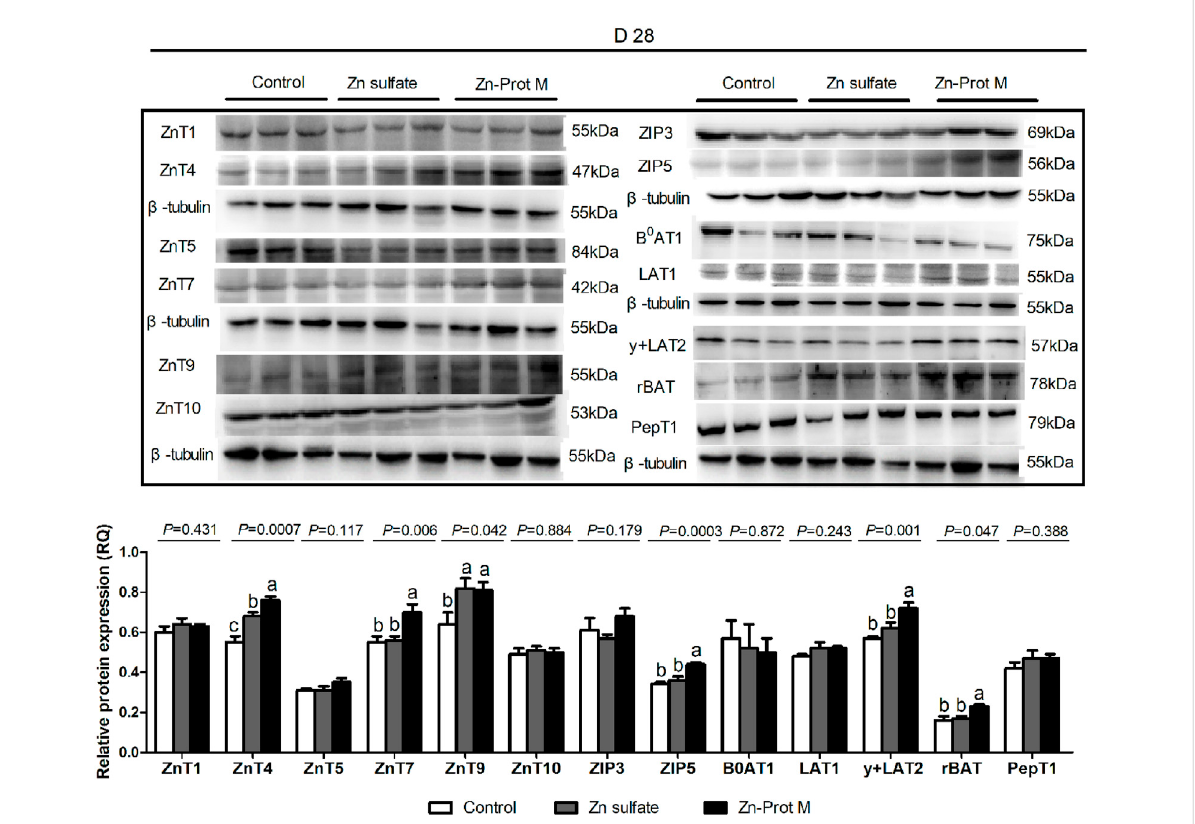
FIGURE 3 Effect of dietary Zn source on the protein expression levels of Zn, amino acid, and small peptide transporters in the duodenum of broilers at 28 daysofage.Valuesaremeans±SE,(n=7/8).Lackingthesameletters(a,b,andc)meanssigni fi cantdifferences, p < 0.05.ZnT1,zinctransporter1; ZnT4, zinc transporter 4; ZnT5, zinc transporter 5; ZnT7, zinc transporter 7; ZnT9, zinc transporter 9; ZIP3, Zrt-irt-like protein 3; ZIP5, Zrt-irt-like protein 5; B0AT1, B-0-system neutral amino acid co-transporter; LAT1, L-type amino acid transporter 1; y + LAT2, y + L-type amino acid transporter 2; rBAT, b0,+-type amino acid transporter; PepT1, peptide-transporter 1; Zn-Prot M, Zn proteinate with moderate chelation strength (Q f = 51.6). The protein expression levels were calculated as the relative quantities (RQs) of the target gene protein to the β -tubulin